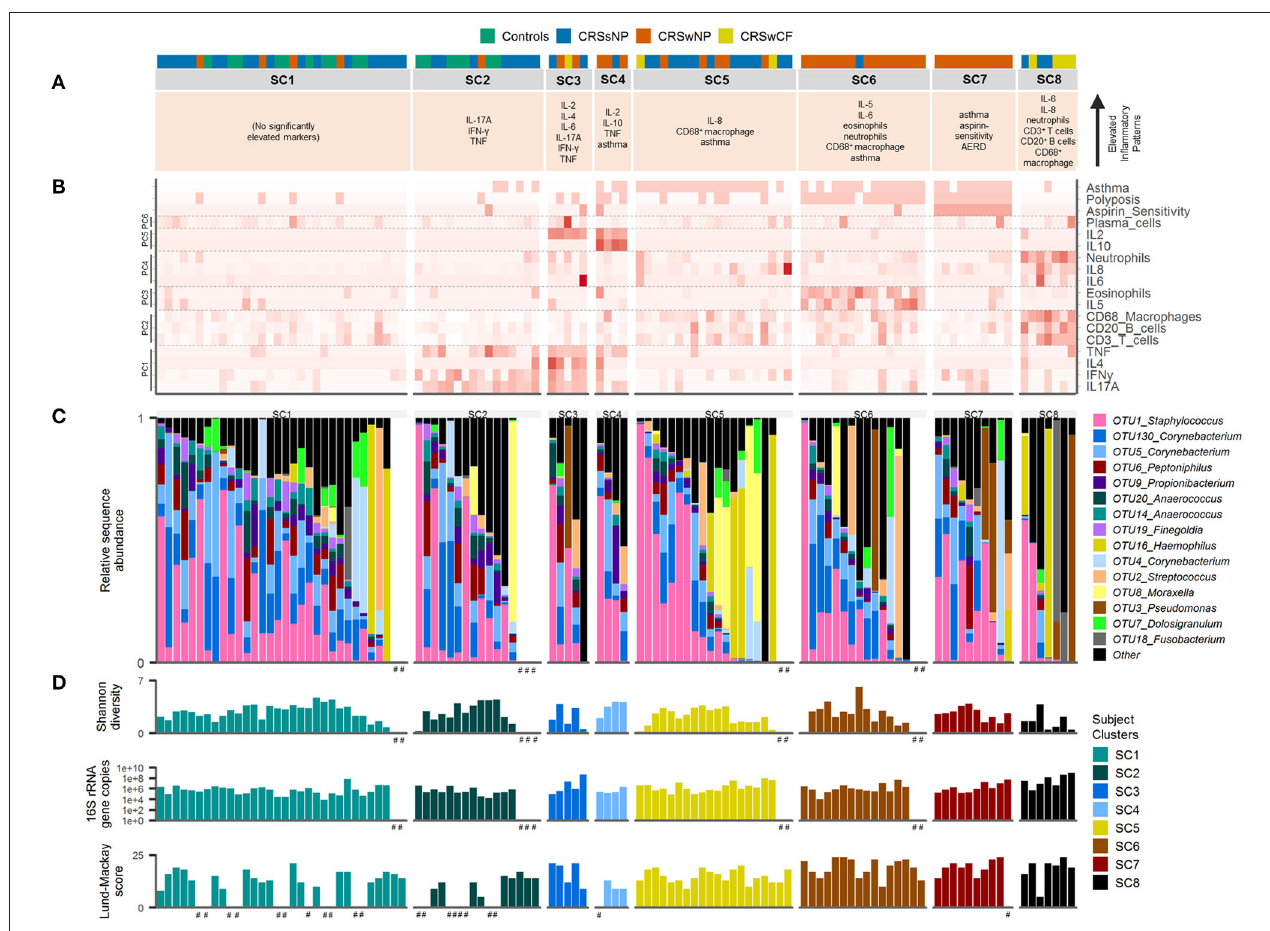
FIGURE 3 | Inflammatory markers and bacterial communities across subject clusters [SC1 ( n = 32), SC2 ( n = 16), SC3 ( n = 5), SC4 ( n = 4), SC5 ( n = 20), SC6 ( n = 16), SC7 ( n = 10), SC8 ( n = 7)]. (A) Characteristic inflammatory patterns reflecting significantly elevated variables ( α = 0.05) compared with at least one other of the eight subject clusters. Color coding above denotes subject phenotype based on polyposis and cystic fibrosis [controls ( n = 17), CRSsNP ( n = 46), CRSwNP ( n = 40), CRSwCF ( n = 7)]. (B) Heat map depicting subject profiles for each of the variables included in the subject clustering. Variables are arranged by principal components analysis results (PC1-6). (C) Taxonomic summary plot of bacterial community assemblages for each subject. (D) Bacterial community diversity (Shannon diversity index) and total bacterial load (shown on a log scale) based on data from Hoggard et al. ( 13), and Lund-Mackay clinical severity scores for each patient. Subjects within each cluster are arranged in descending order of the sum of the relative abundances of the eight “healthy-associated” bacterial OTUs discussed in this study. # no data